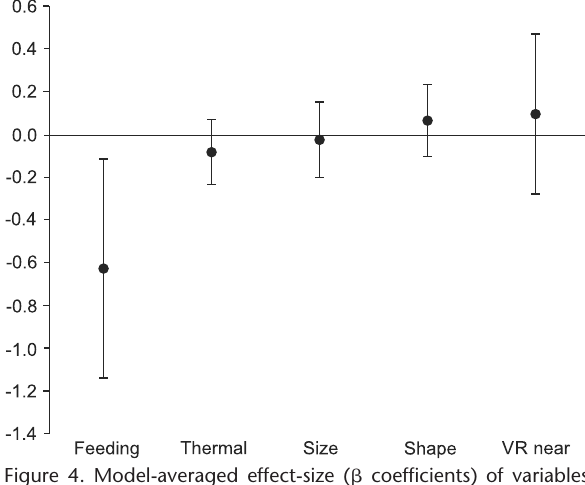
Figure 4. Model-averaged effect-size ( (cid:2) coefficients) of variables from the 32-model set. Error bars show 95% confidence limits, where they do not intersect the dotted line, we consider the effect of the variables on vegetation remnant occupancy to be